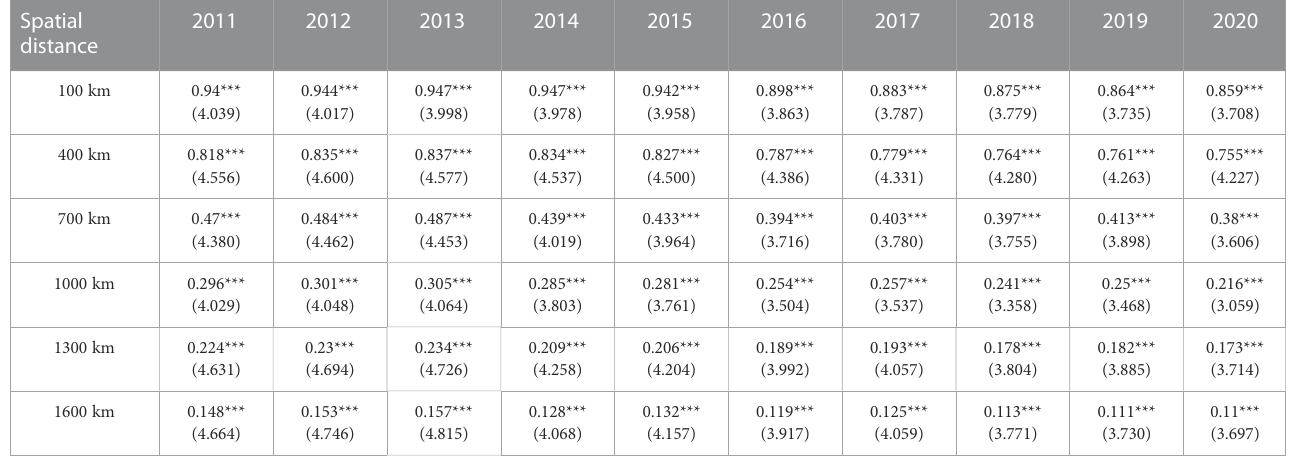
TABLE 4 Moran ’ s I index of rural revitalization under different spatial distance